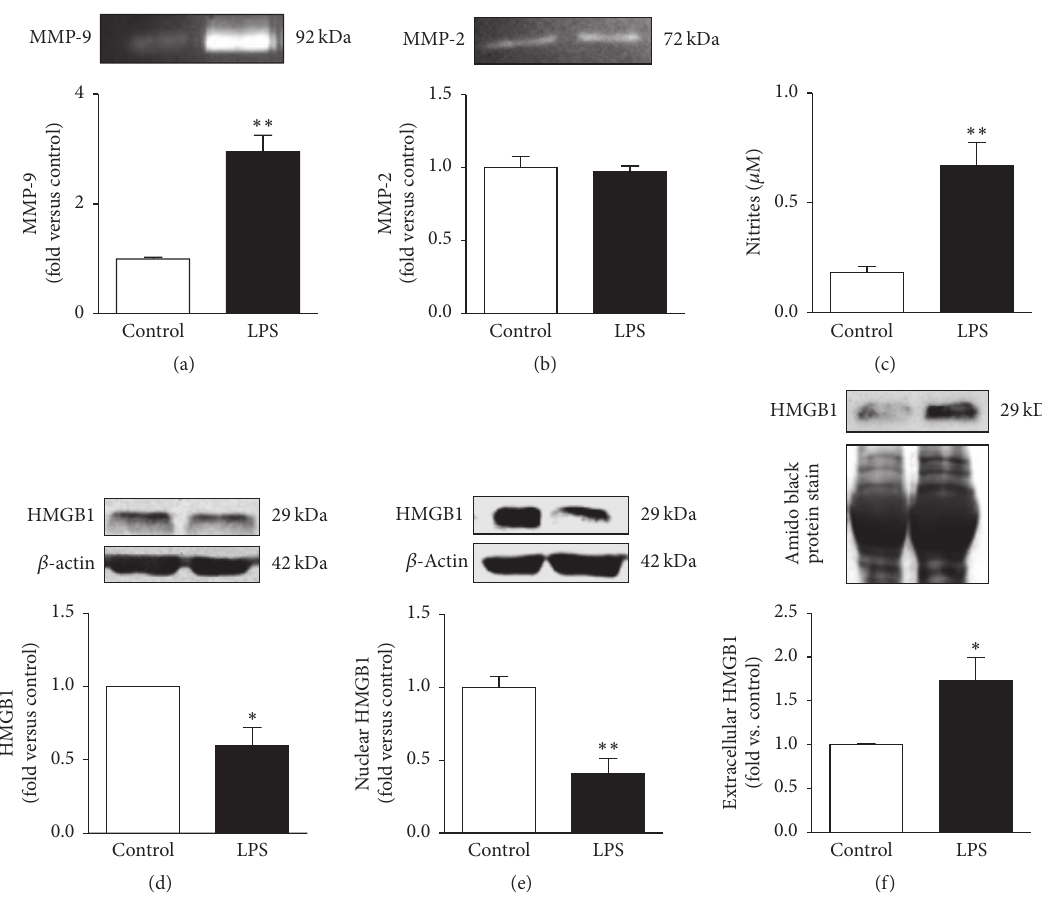
Figure 6: M1 polarized N9 microglia have low intracellular content of HMGB1 and increased secretion of MMP-9, NO, and HMGB1 to the cell milieu. Extracellular medium was assessed for matrix metalloproteinase-9 (MMP-9) (a) and MMP-2 (b) activities by the gelatin zymography assay and results were expressed as fold versus nontreated cells (control). Nitrites that reflect nitric oxide (NO) production were assessed by theGriessreactionfollowedbyMicroplateReaderforAbsorbanceAssays(c).Highmobilitygroupbox1(HMGB1)expressionwasdetermined in total extracts (d), nuclear fraction (e), and extracellular media (f) by Western blot analysis. Results are mean ± s.e.m. from six (a, b, d, e) or four (c, f) independent experiments. Nitrites measurement (c) was performed in duplicate. Comparisons between lipopolysaccharide- (LPS-) treated N9 cells and nontreated cells (control) were made via two-tailed Student’s 𝑡 -test (e) or unpaired 𝑡 -test with Welch’s correction (a, c, d, f). ∗ 𝑝 < 0.05 and ∗∗ 𝑝 < 0.01 versus nontreated cells